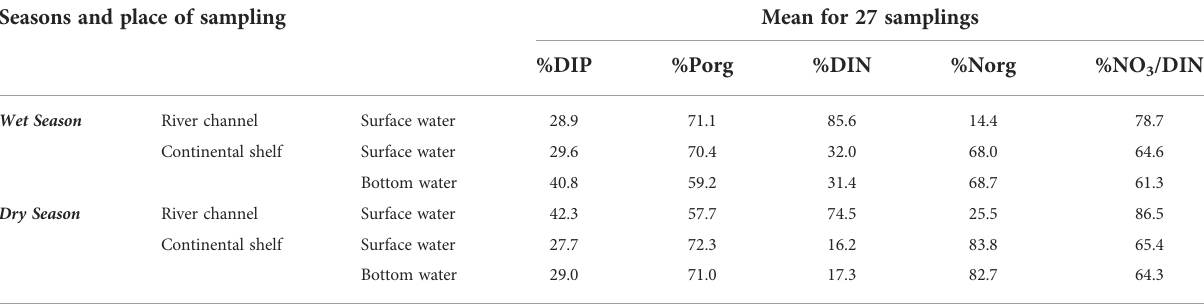
TABLE 4 Dissolved nutrients percentage in the total content of nitrogen and phosphorus. DISSOLVED NUTRIENTS IN TOTAL CONTENT Seasons and place of sampling